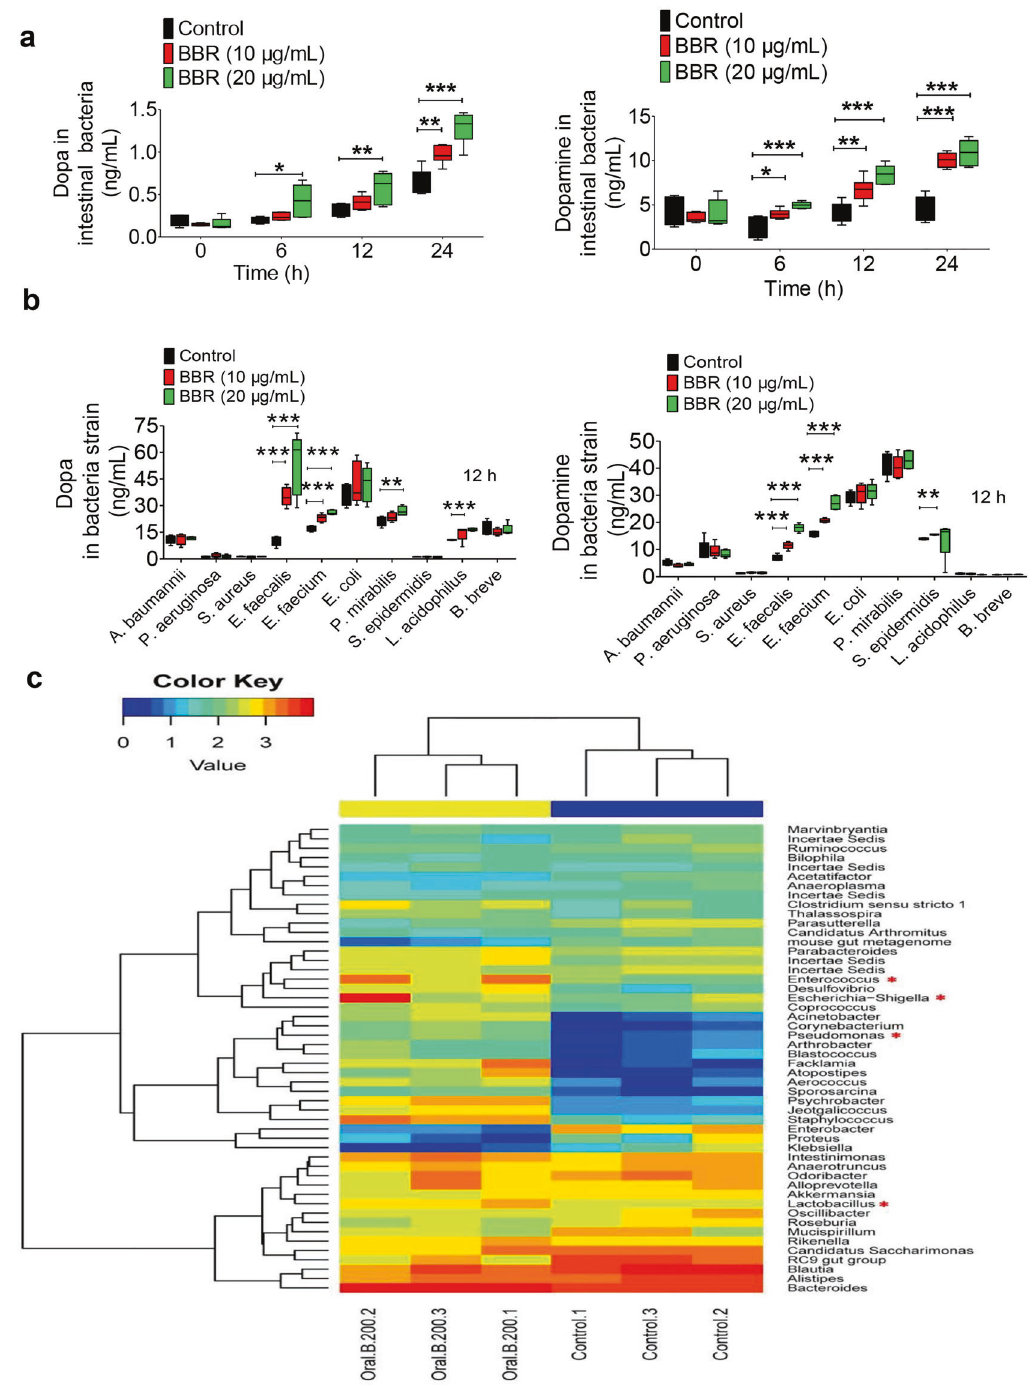
Fig. 2 BBR stimulated intestinal bacteria to produce dopa/dopamine. a Levels of dopa/dopamine increased signi fi cantly at 0, 6, 12, and 24 h after BBR treatment (10 and 20 μ g/mL, respectively) in the intestinal bacteria of SD rats in vitro (mean ± SD, * P < 0.05, ** P < 0.01, and *** P < 0.001, for dopa and dopamine). b Effect of BBR (10 μ g/mL) in ten intestinal bacterial strains in vitro. Out of the ten strains, four bacterial strains ( E. faecalis, E. faecium , P. mirabilis , and L. acidophilus ) showed a signi fi cant increase in dopa after BBR treatment (10 and 20 µg/mL for 12 h), six had almost no change in dopa production. Of note, the increase in dopa by E. faecalis and E. faecium showed a dose-dependent manner with BBR. The BBR-induced dopamine production pro fi le in the ten strains was different from that of dopa, that is, three bacterial strains ( E. faecalis, E. faecium , and S. epidermidis ) showed a signi fi cant increase in dopamine after BBR treatment (10 µg/mL for 12 h), seven had almost no change on dopamine production. Of note, the increase in dopamine by E. faecalis and E. faecium showed a similar dose-dependent manner with BBR. c Changes in the intestinal bacterial composition as a result of BBR treatment. The heat map of the top 50 bacterial genera exhibited the most substantial change in abundance after exposure to BBR; the proportion of dopa/dopamine-producing bacteria increased, including Enterococcus , Escherichia – Shigella , Pseudomonas , and Lactobacillus (labeled with the red “ * ”